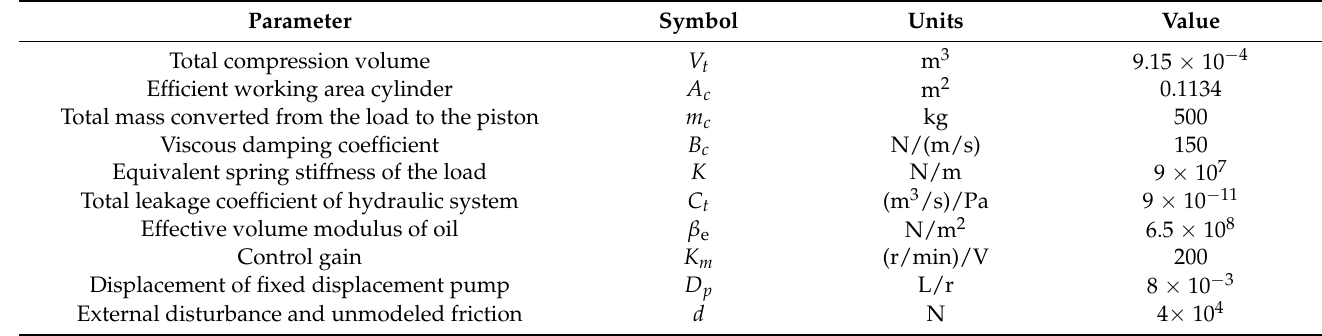
Table 1. Operating parameters of experimental platform.